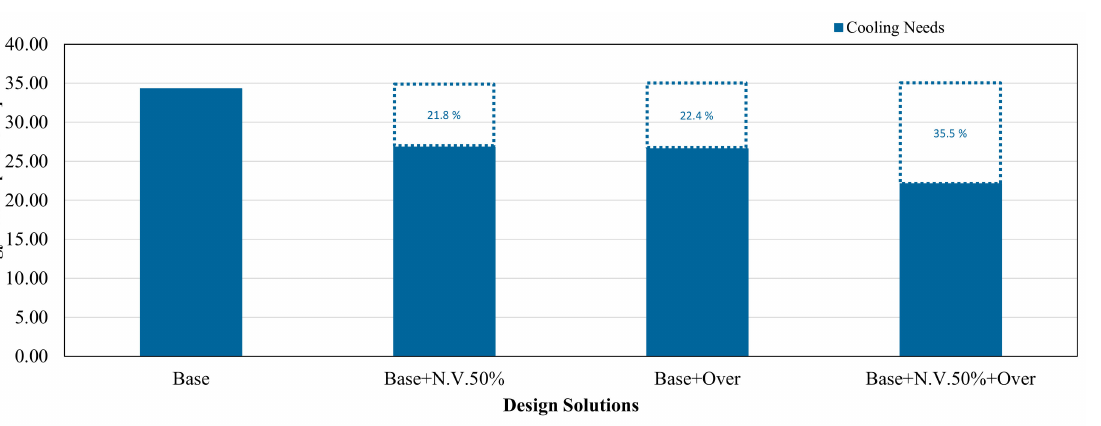
Figure 6. Cooling energy needs for all the investigated